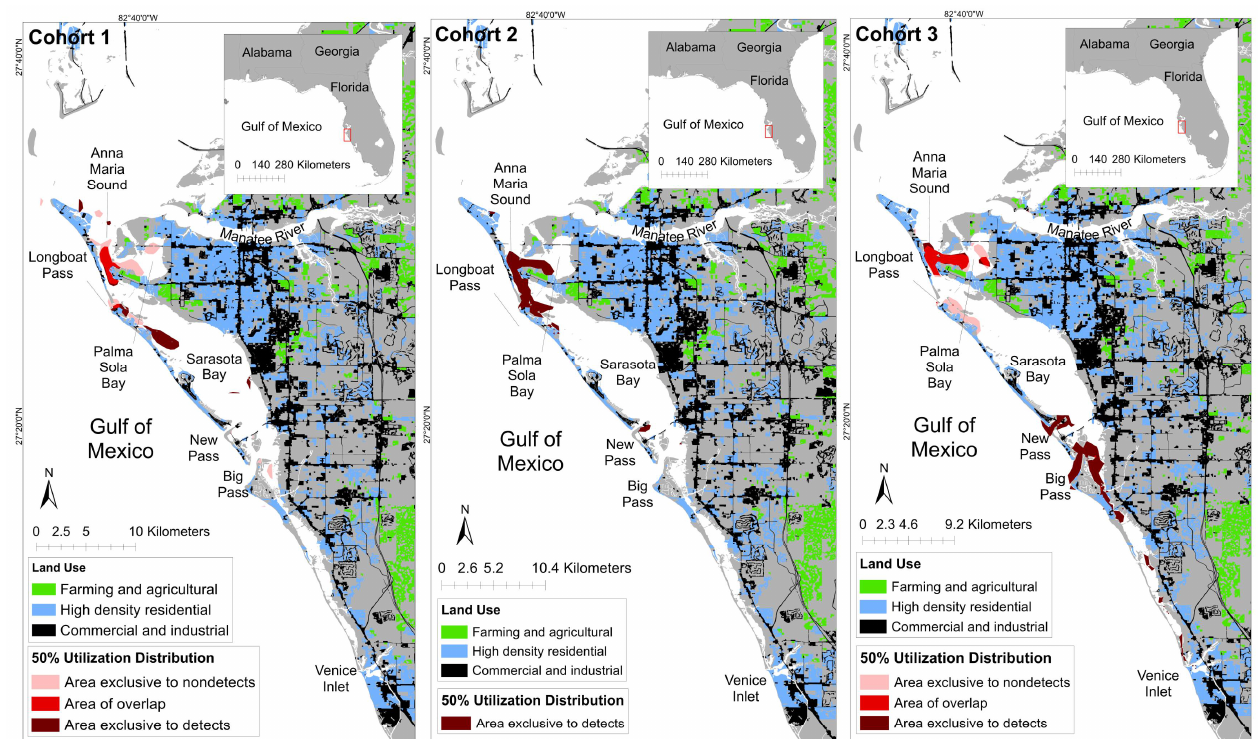
Figure 4. Spatial use of bottlenose dolphins in the Sarasota Bay study area (2010–2019) with detectable (detect) and nondetectable (nondetect) mono(2-ethylhexyl) phthalate (MEHP) concentrations. Photo- identification sighting histories for detect and nondetect individuals were grouped into cumulative ranging patterns with core (50% utilization distributions (UDs)) areas calculated for each temporal grouping (Cohort 1, Cohort 2, or Cohort 3). Study area indicated by the red box. Land use layer obtained from the Southwest Florida Water Management District geospatial open data portal